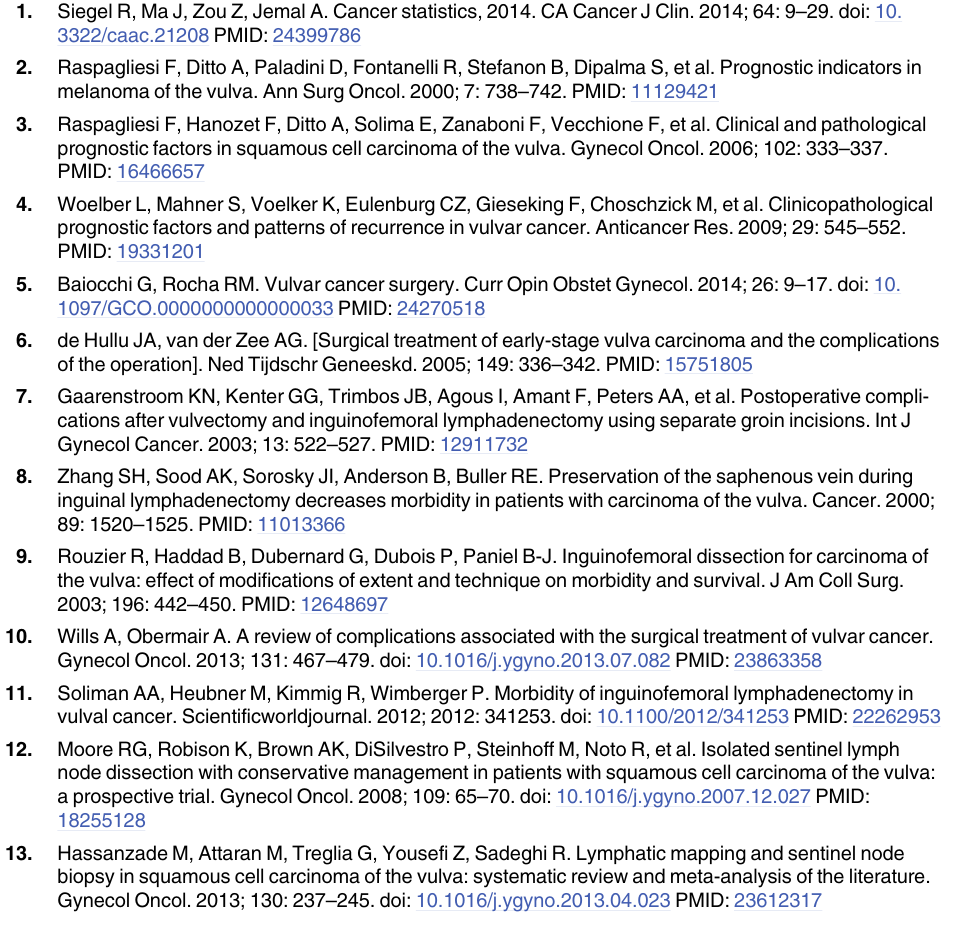
S1 Fig. Flowchart of the Selection Process for Studies Included in the Systematic. Fig